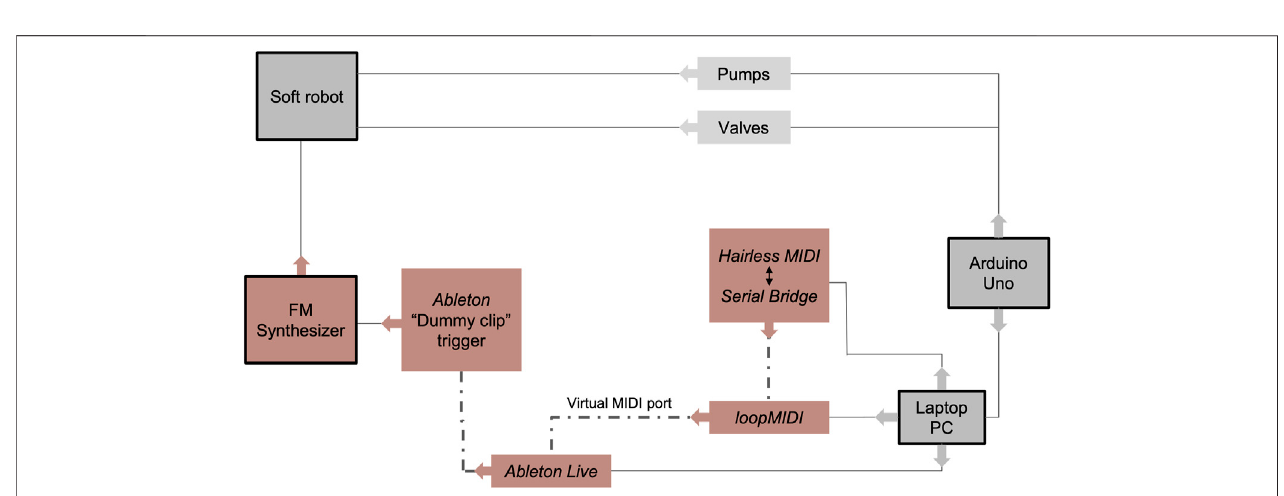
FIGURE 3 | Diagram of the technical system. Gray boxes indicate physical elements and red boxes software applications and protocols.